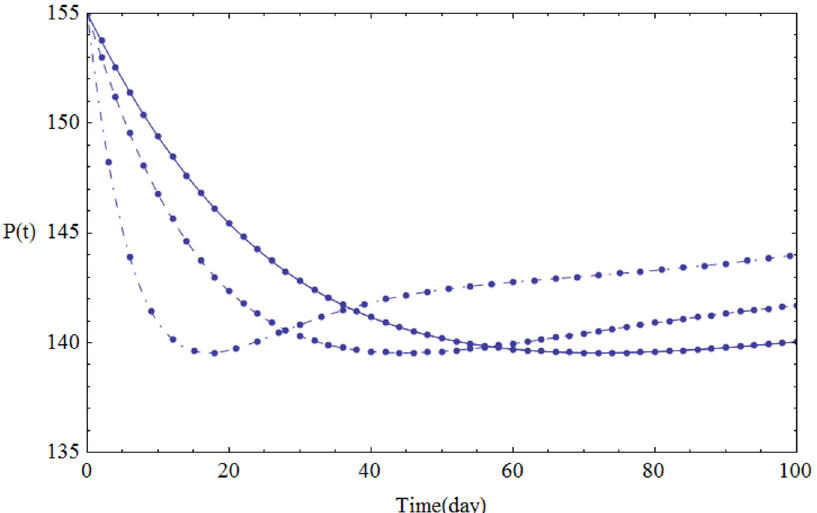
Fig 1. The population of P ( t ) versus t: α = 1.0 (solid line), α = 0.95 (dashed line) and α = 0.85 (dot- dashed